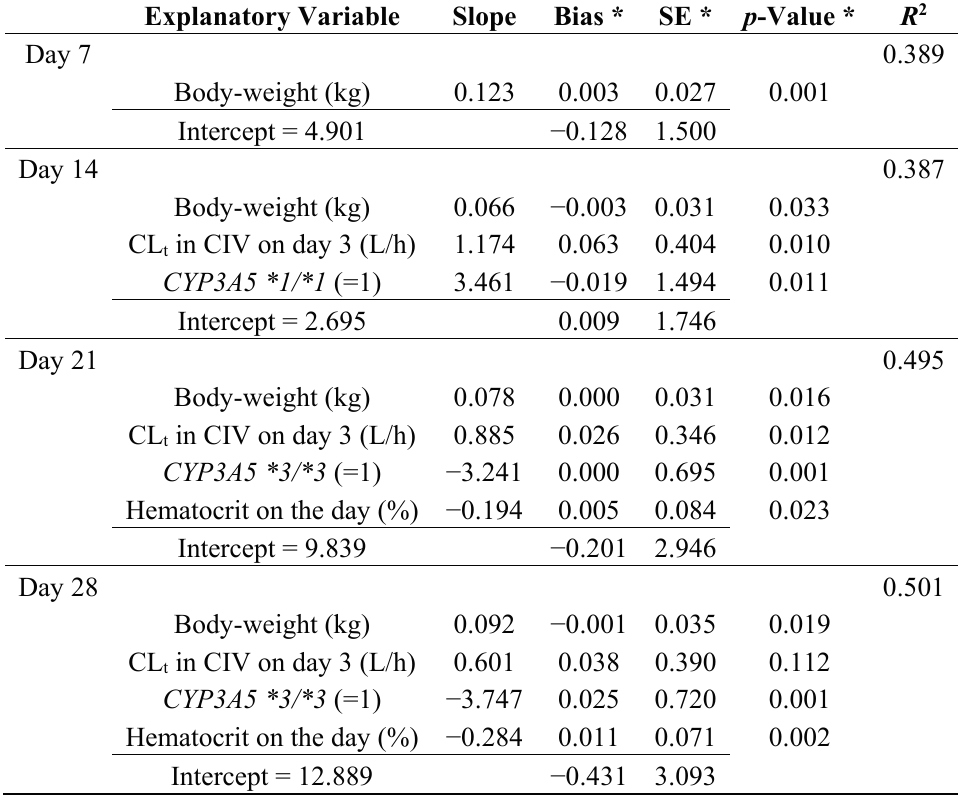
Table 3. Stepwise selection multiple linear regression analysis of explanatory variable for tacrolimus daily dose after renal